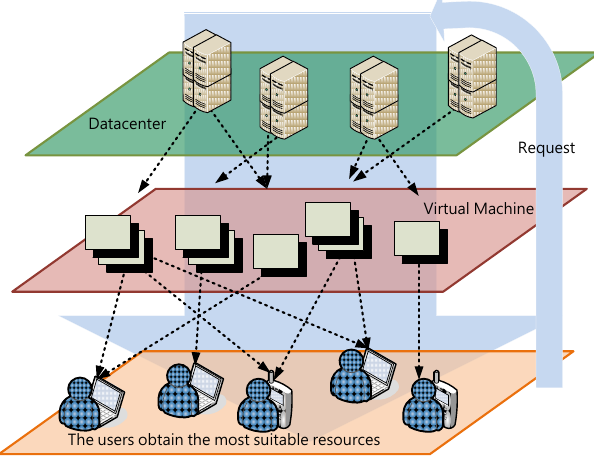
Figure 1. Cloud resource allocation